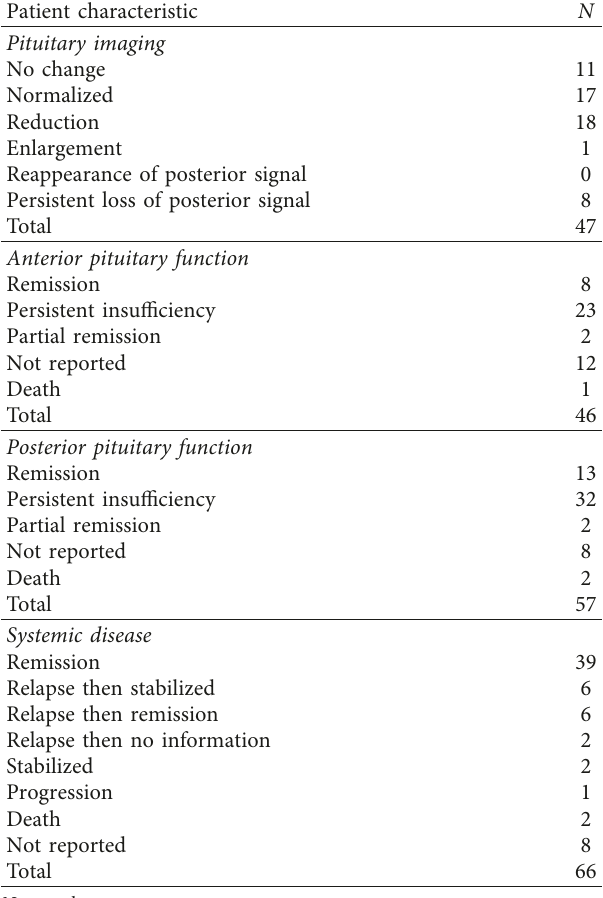
Table 2: Follow-up of patients with GPA-related pituitary disease. Patient characteristic